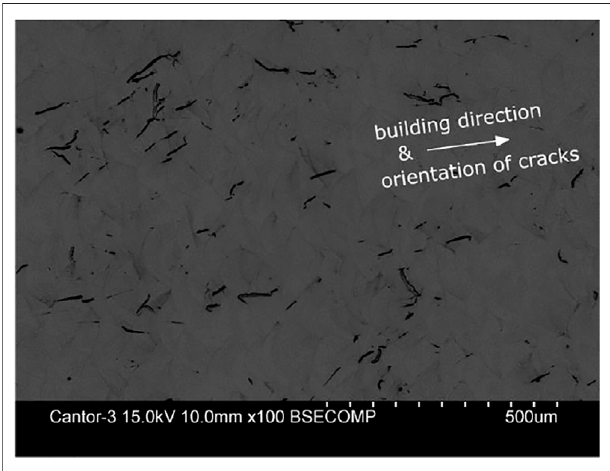
FIGURE 11 | Cross-sectional SEM image of the 3D-printed #3 Cantor alloy